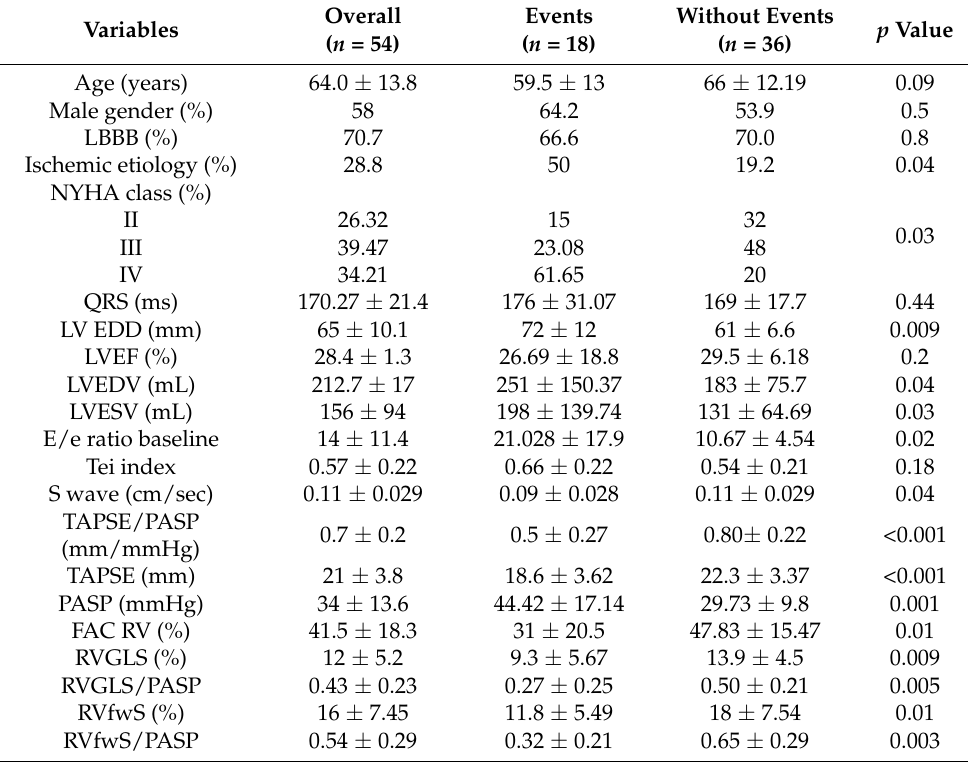
Table 1. Characteristics of the entire cohort and divided in two subgroups according to the occurrence of adverse cardiovascular events (death and HF